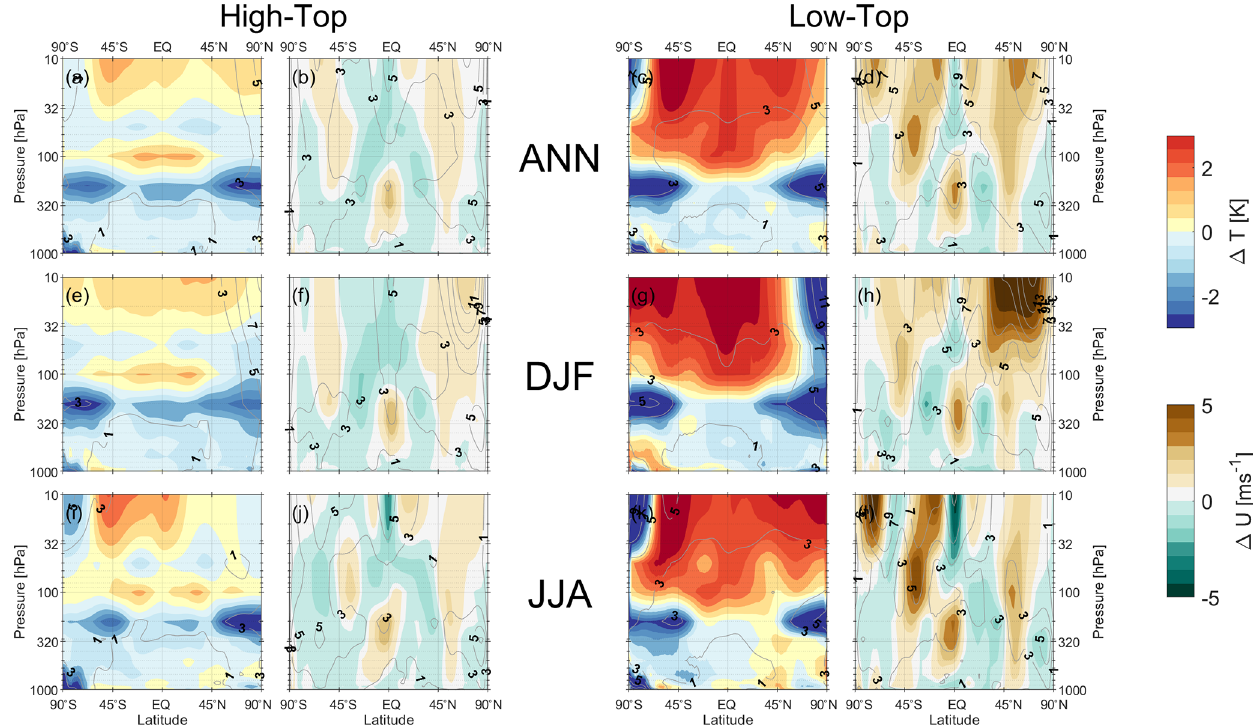
Figure 2. Zonal-mean (a, c, e, g, i, k) temperature and (b, d, f, h, j, l) zonal-wind biases as a function of pressure and latitude at a lead time of 4 weeks. Data are averaged over (a–d) the full annual cycle (ANN), (e–h) boreal winter (DJF), and (f–l) austral winter (JJA) and are shown separately for (a, b, e, f, i, j) high-top and (c, d, g, h, k, l) low-top models. The grey-line contours show the composites of mean absolute errors from each